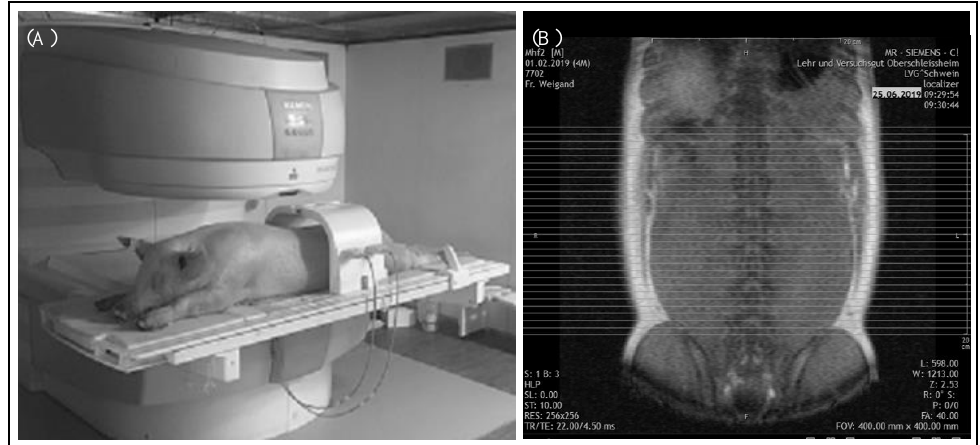
Figure 1. MRI examination of the abdomen. ( A ) Position of the pig for the examination of the abdomen by a Siemens Magnetom C! system. ( B ) Localizer of the “ViscFat-Sequence” with defined area encompassing visceral adipose tissue. Each line represents an axial sectional image of the abdomen starting at the origin of the last rib to the top of the iliac crest.